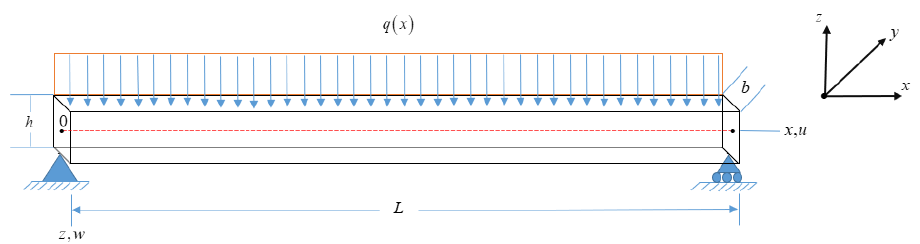
Figure 2. Geometry of a piezoelectric beam with simply supported boundary conditions, subjected to uniformly distributed load q ( x )